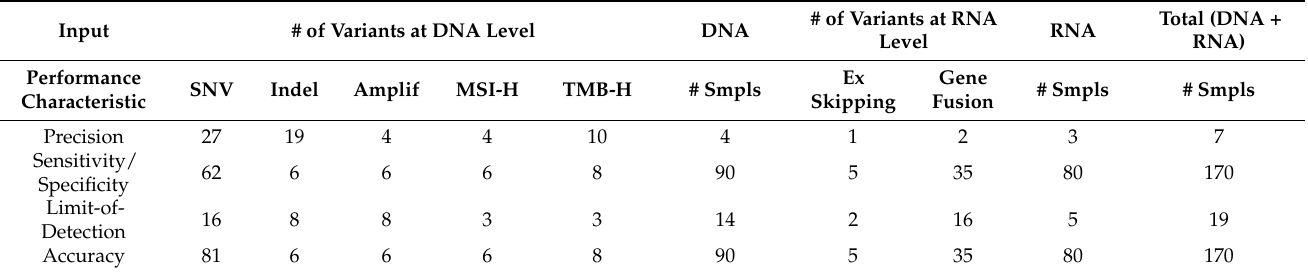
Table 1. Overview of the number of variants or biomarkers assessed for each performance character- istic of the TSO500 validation study. The number of samples used are also